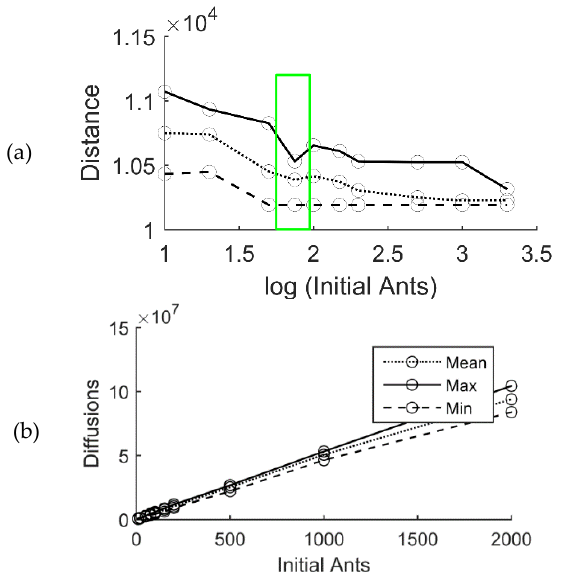
Figure 6. (a): Minimum, maximum, and mean diagram of the distance of solutions concerning initial ants. (b): Minimum,